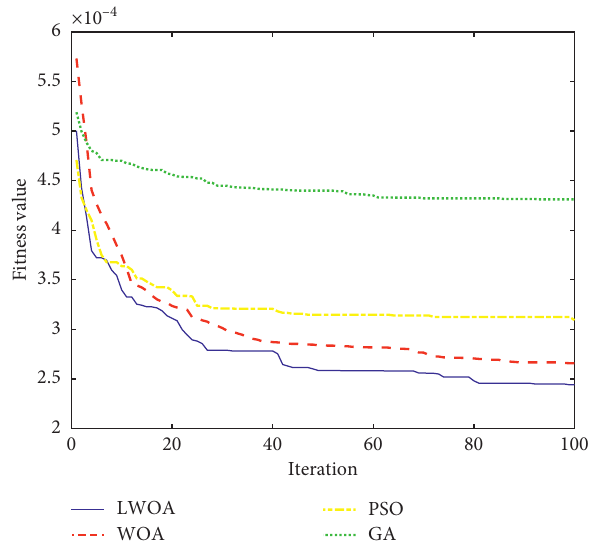
Figure 5: Convergence curves for LWOA, WOA, PSO, and GA.